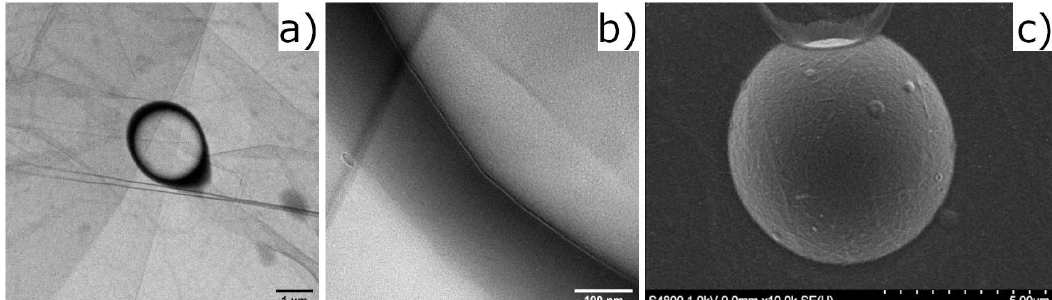
Figure 5. TEM image taken at 200 kV in cryo conditions of ( a ) zoomed out droplet, and ( b ) zoomed in on the border. The droplet exploded due to radiation damage from the electron beam, and, therefore, the shell is bent outwards from the border. ( c ) SEM image taken of the droplet, showing the coherent fibrous layer at the interface. The image is the original image produced by the software connected to the microscope, and the scale bar beneath the image is in